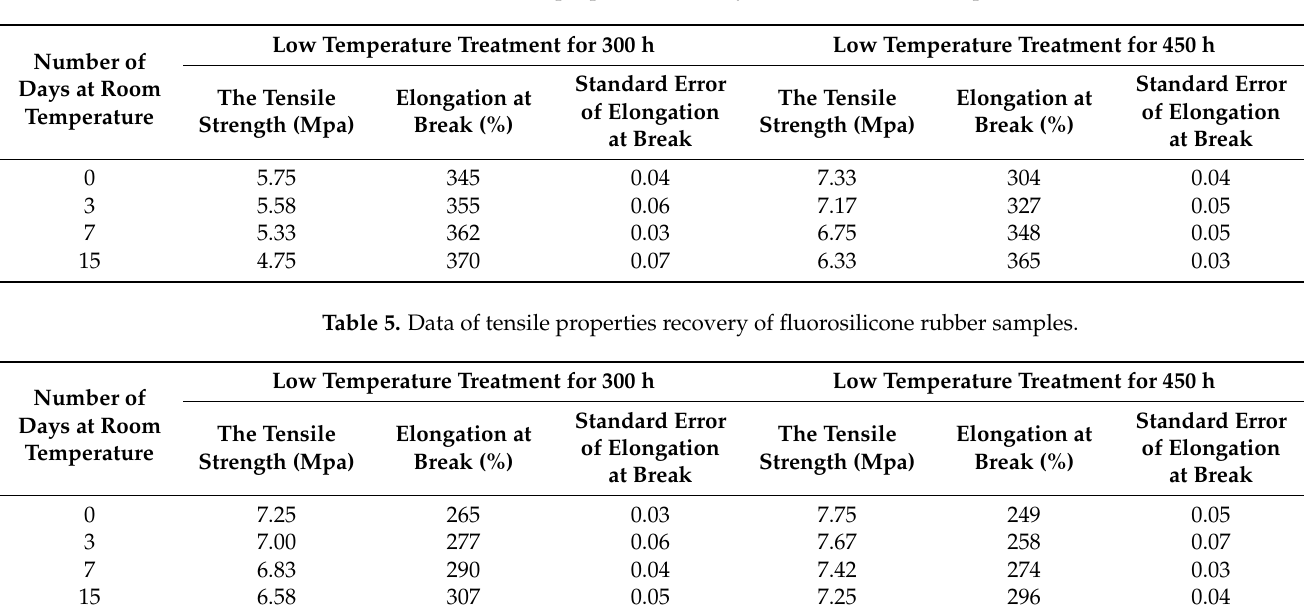
Table 4. Data of tensile properties recovery of silicone rubber samples.